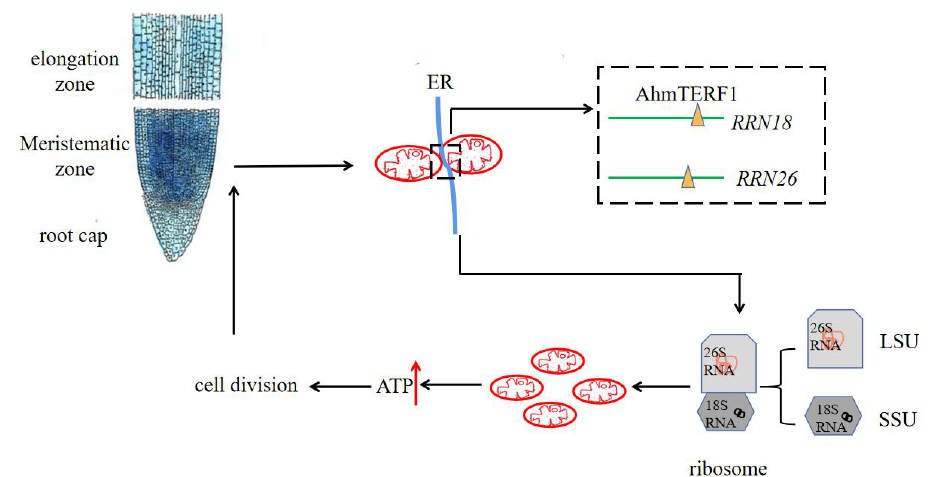
Figure 9. Working model of AhmTERF1 function.